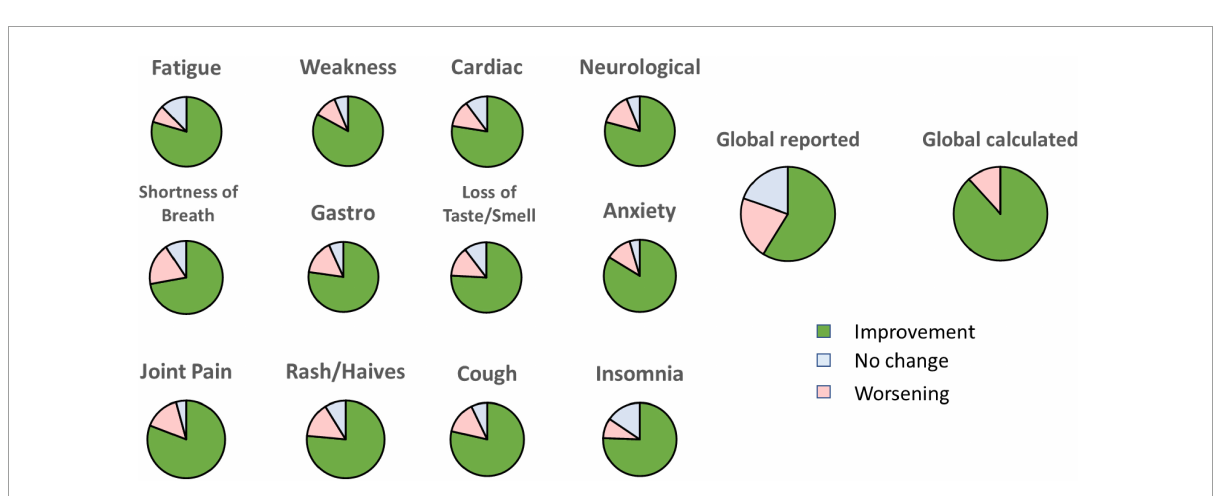
FIGURE4 Percentage of participants reporting an improvement, no change or worsening for each symptom at week 4 relative to baseline. “Global reported” is the score given by each participant on general feeling. “Global calculated” is the average of all the scores for each